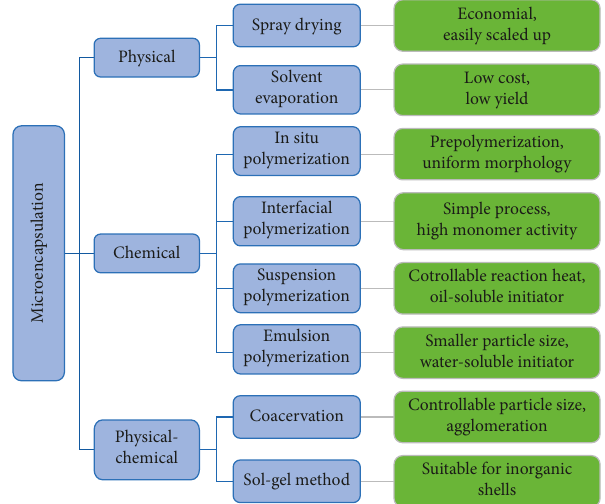
Figure 3: The classification of microencapsulation methods for